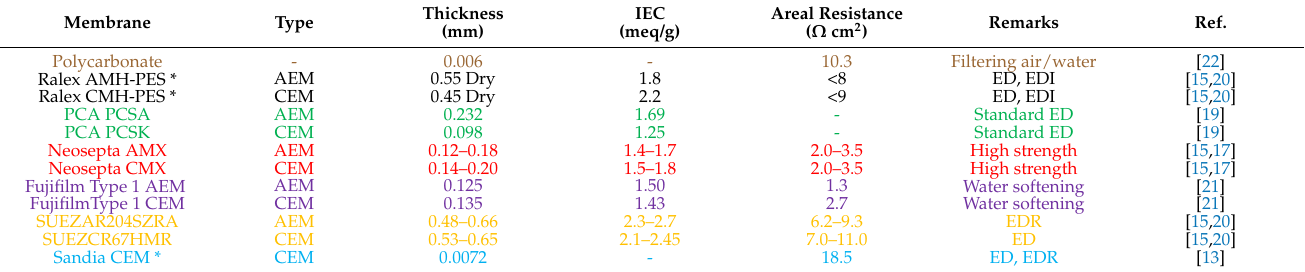
Table 2. Standard properties of IEMs used in this study